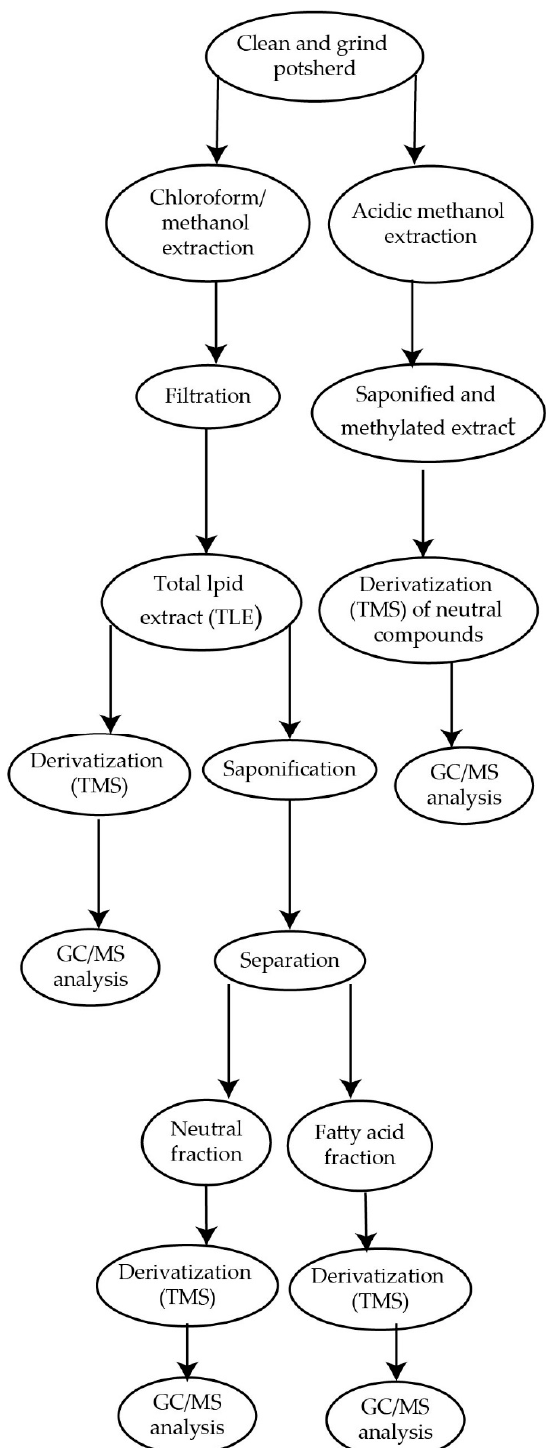
Figure 1. Extraction methods used in this paper.